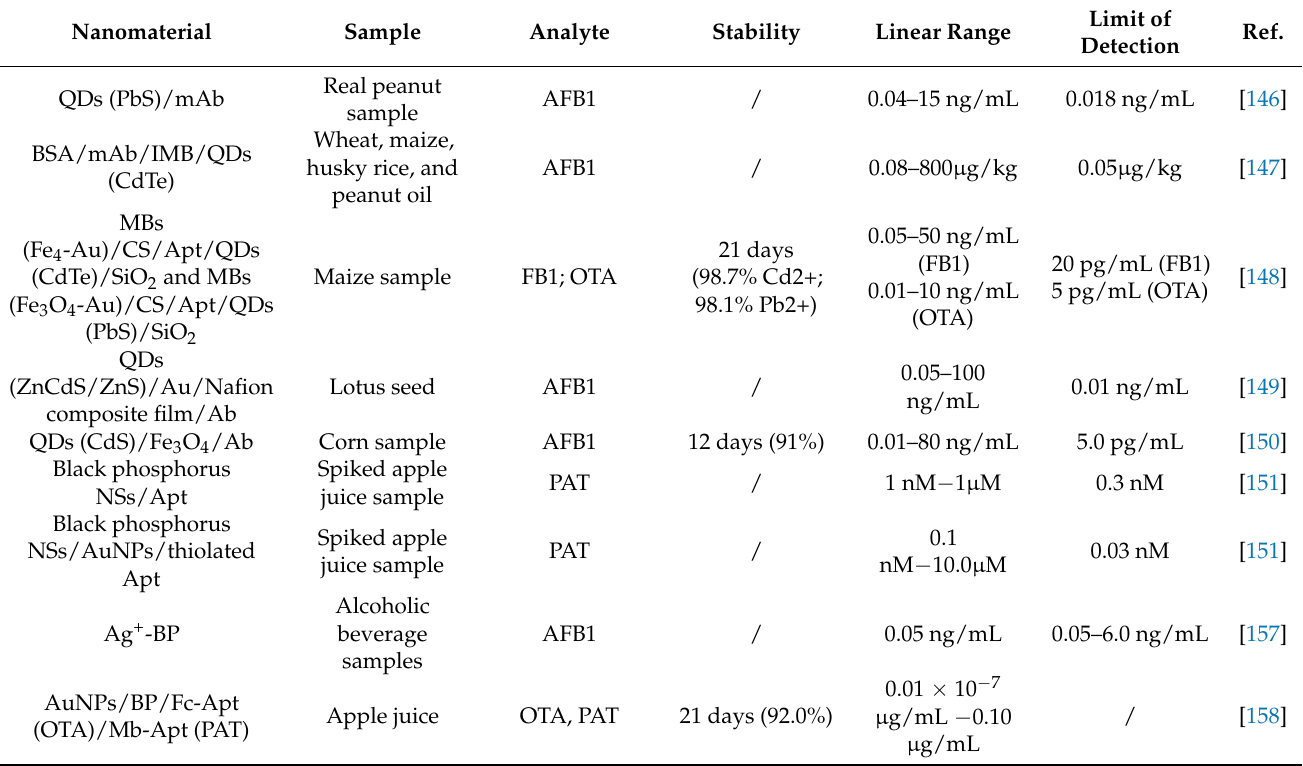
Table 8. Representative studies of electrochemical biosensors for detecting mycotoxins from food samples by other